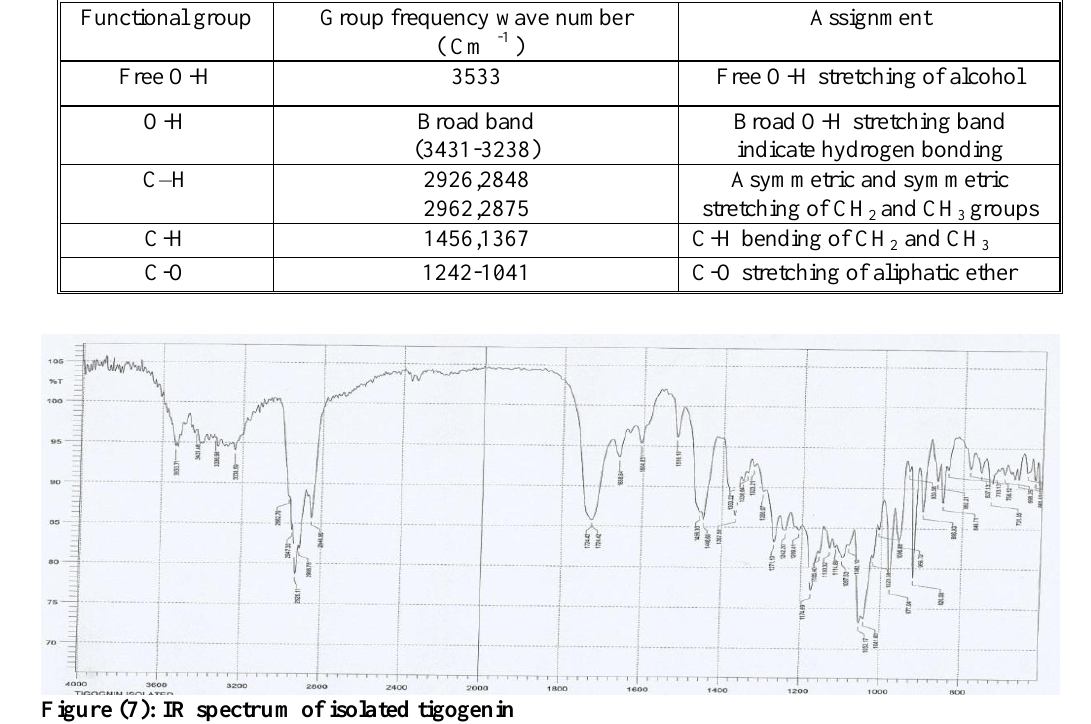
Figure (7): IR spectrum of isolated tigogenin